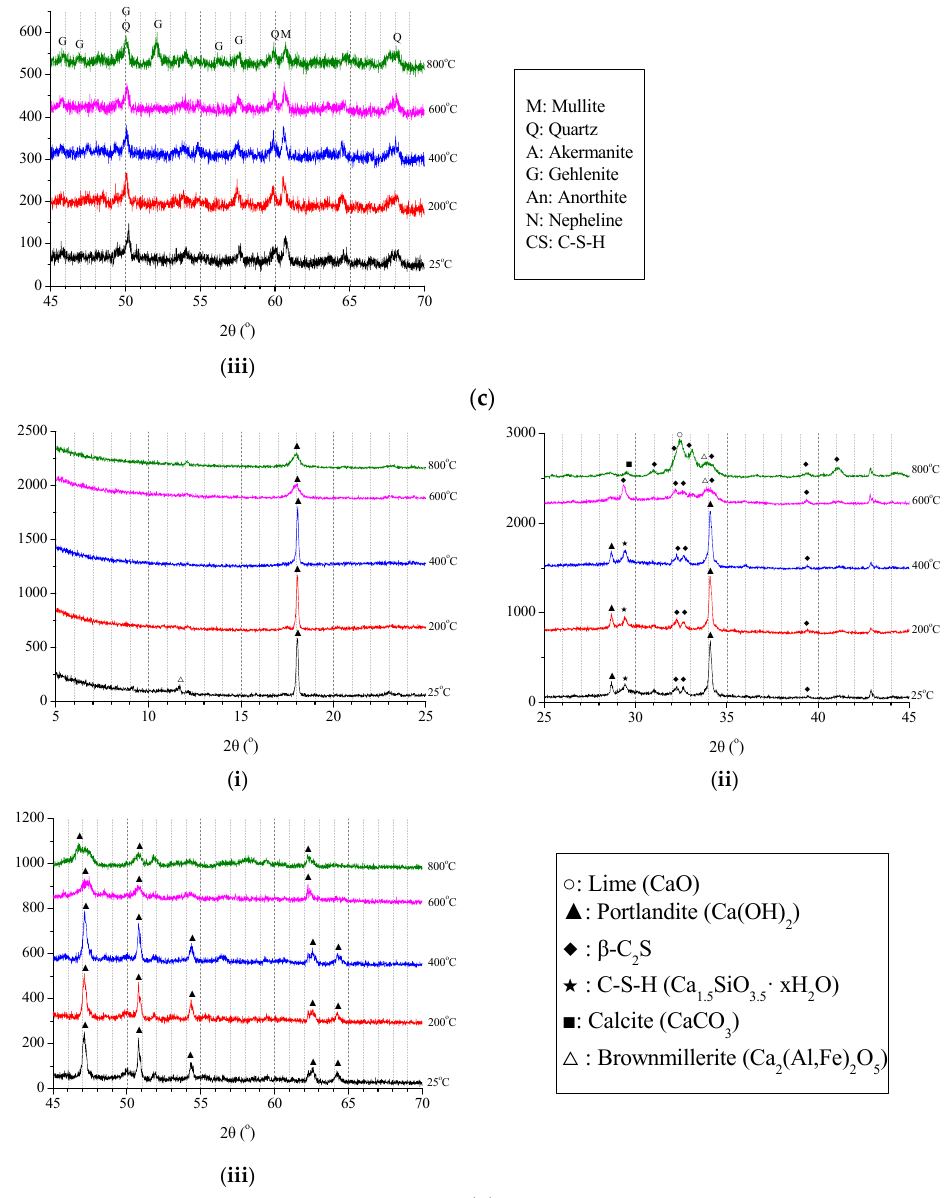
Figure 15. XRD results of geopolymer and ordinary paste after exposure to elevated temperature: ( a ) GP-C30; ( b ) GP-C40; ( c ) GP-C50 and ( d ) OP-C40.3.4.3. SEM Results.